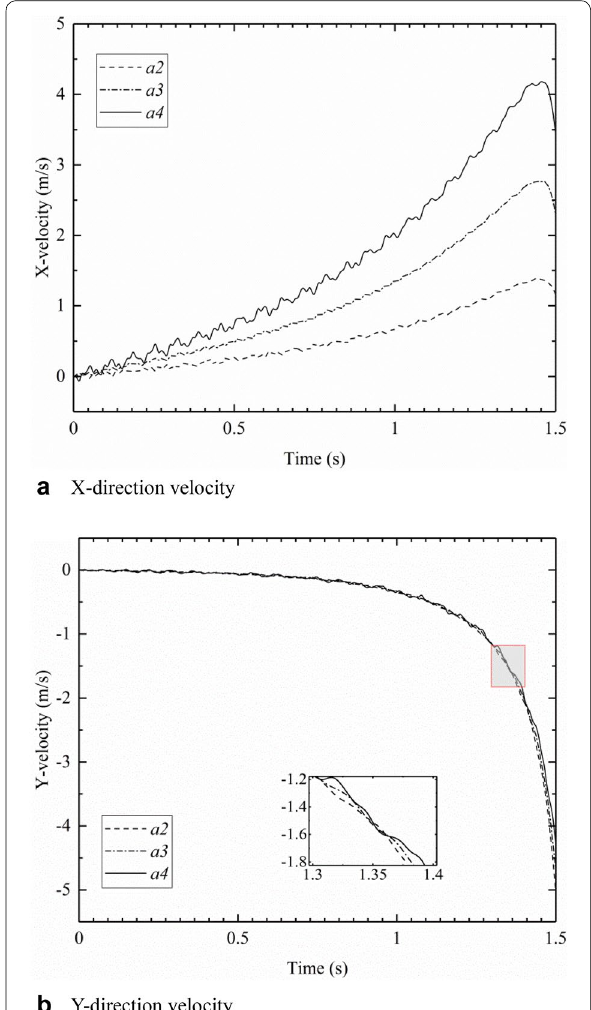
Figure 8 Displacement of point a 2 , a 3 , a 4 Figure 9 Velocity of point a